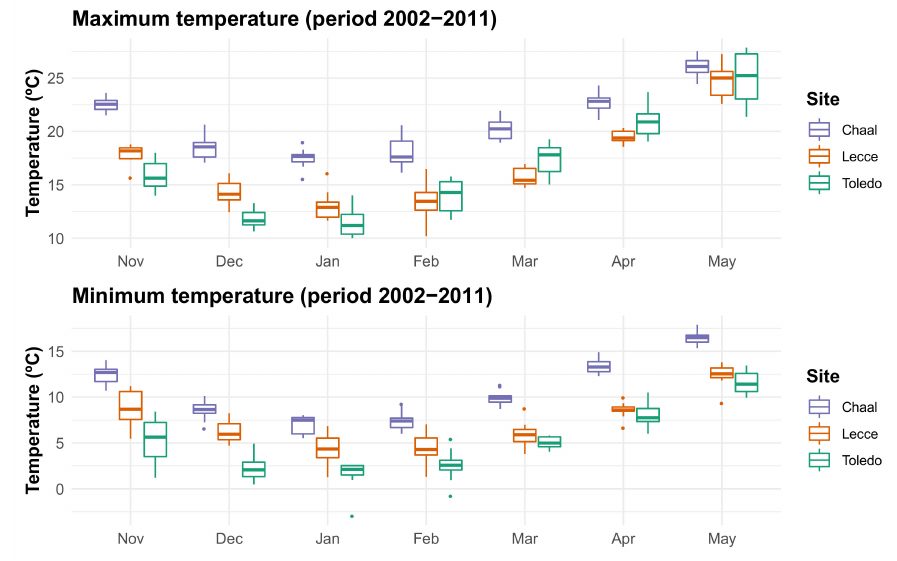
Figure 2. Meteorological data (average monthly maximum and minimum temperature) between the di ff erent sampling stations. Calculated for the period common to the three stations,